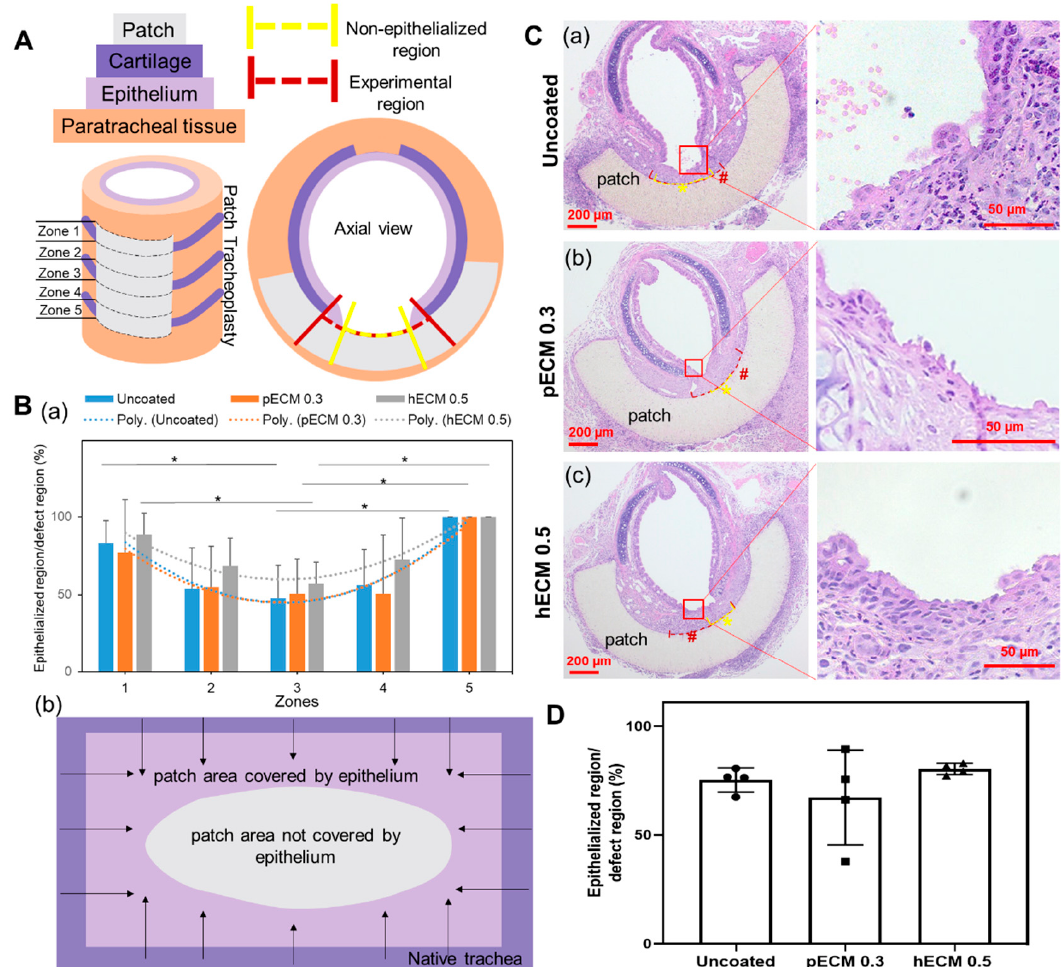
Figure 3. The epithelialization of the pECM- and hECM-coated patches of syn-TG in vivo. ( A ) Schematic definition of the regions for the epithelium coverage calculations. ( B ) Regional cell coverage. (a) Quantification of the overall cell coverage in 5 regions and the second degree of the polynomial regression curves. * Denotes the differences between zone 3 and zone 1 and zone 3 and zone 5 (uncoated zone 1 vs. zone 3: p = 0.0366, uncoated zone 3 vs. zone 5: p = 0.0155, pECM 0.3 zone 3 vs. zone 5: p = 0.0217, hECM 0.5 zone 1 vs. zone 3: p = 0.0179, and hECM zone 3 vs. zone 5: p = 0.0082). (b) A schematic top view of the patch luminal surface indicated by the quantification; arrows denote the epithelial regeneration of the patch. ( C ) Representative cross-section H&E images of a trachea section with a patch implanted: (a) uncoated, (b) pECM 0.3-mg/mL, and (c) hECM 0.5-mg/mL-coated patches. * Represents the noncovered lengths of the dashed lines along the patches. # Represents the experimental (defect) lengths of the longer dashed lines along the patches. Regenerated cell length was calculated by experimental (defect) length minus non-covered length. ( D ). Quantification of overall cell coverage calculated by the regenerated cell width/experimental width × 100%.